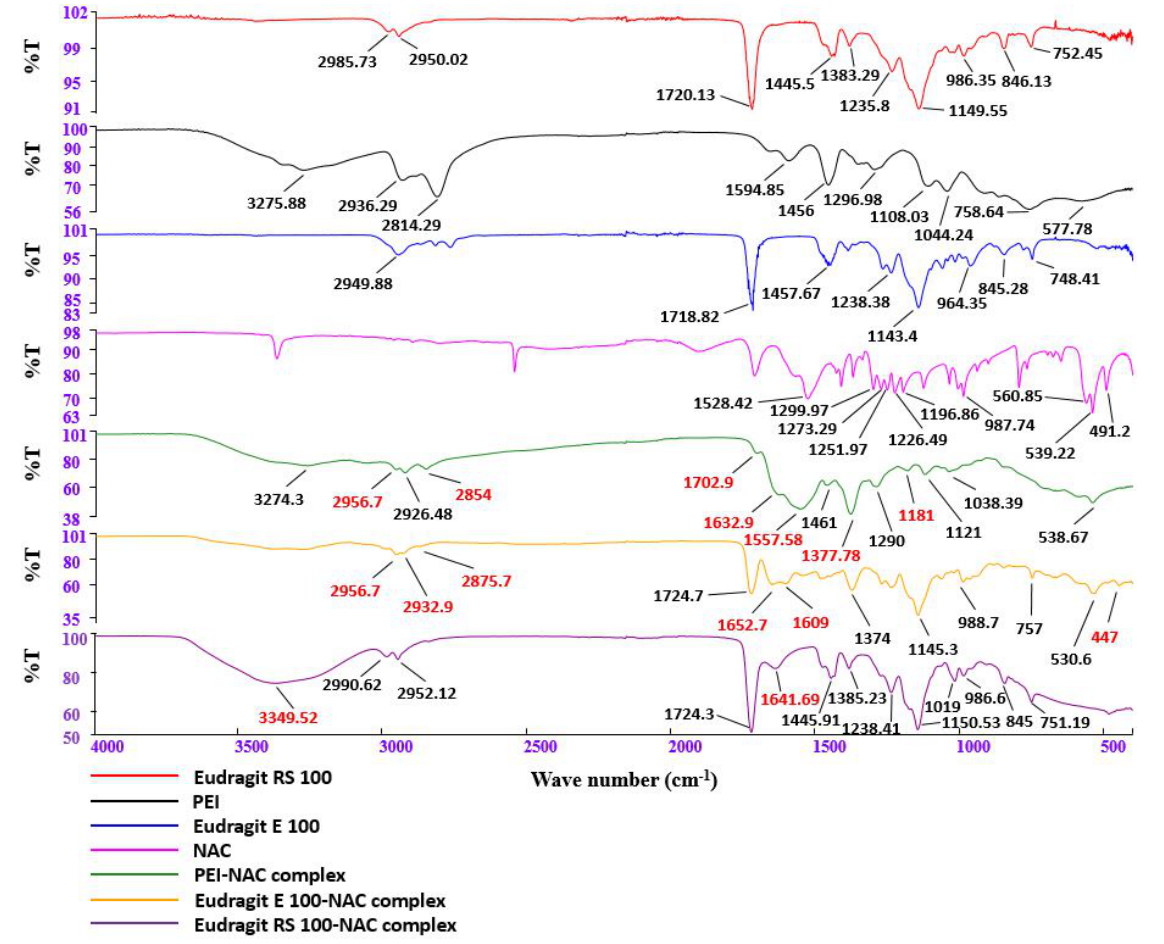
Figure 3. FT-IR spectroscopy of N -acetylcysteine, polymers (PEI, Eudragit E 100, and Eudragit RS 100), and NAC polymer ionic